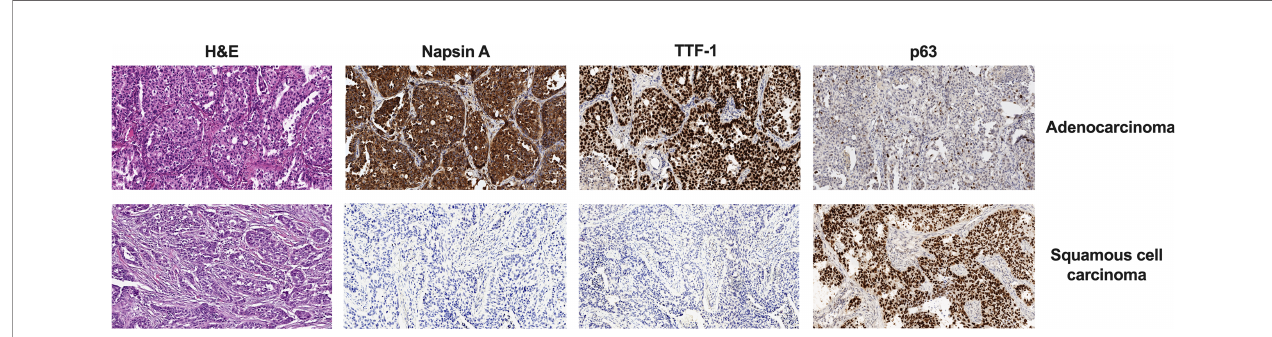
FIGURE 1 | Difference in H&E and IHC staining of two histologic types of NSCLC. Magni fi cation, ×100. IHC, immunohistochemistry; NSCLC, non-small cell lung